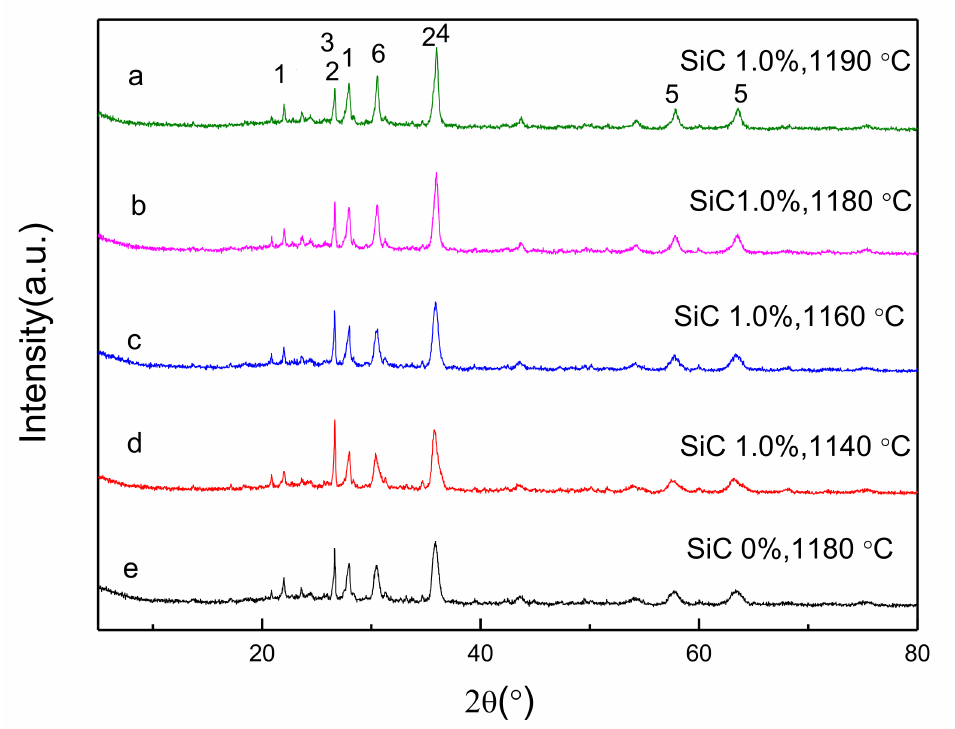
Figure 6. The XRD patterns of ceramsite at different temperatures [1, Albite-low-Na(AlSi 3 O 8 ); 2, Kyanite-Al 2 SiO 5 ; 3, Quartz-SiO 2 ; 4, Fayalite-Fe 2 (SiO 4 ); 5, Hematite -Fe 2 O 3 ; 6,